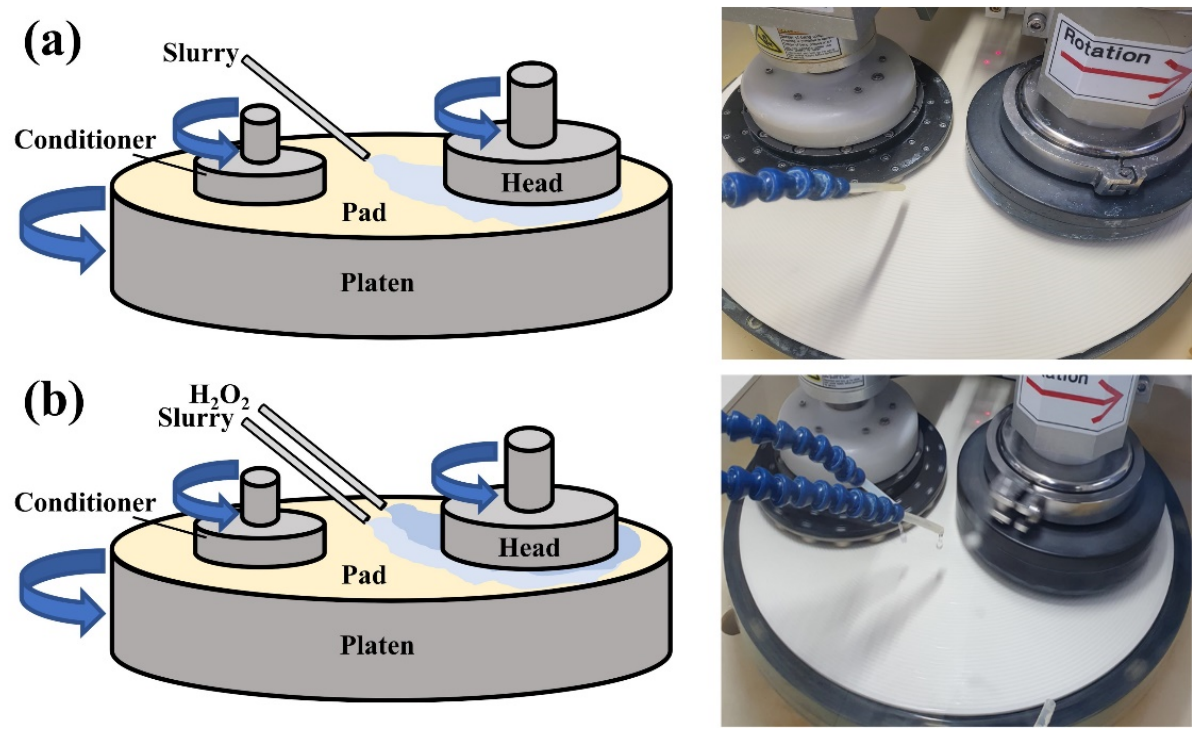
Figure 1. Images of ( a ) the general injection method and ( b ) the two-way injection method.